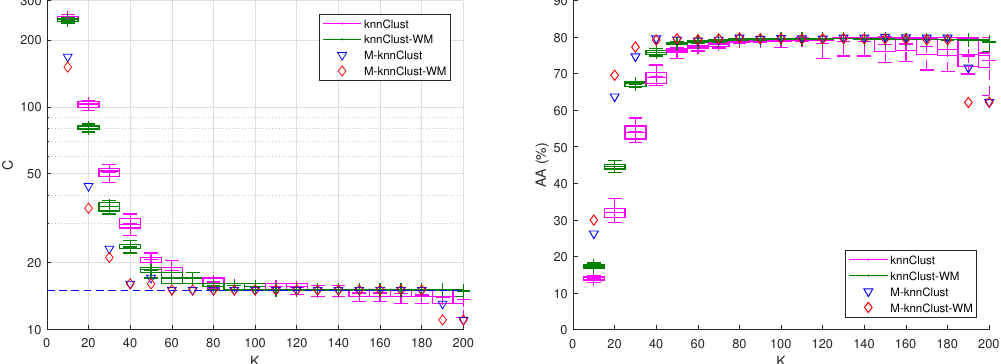
Figure 4. Comparison of KNNCLUST (black circles, 10 runs), M - KNNCLUST (blue triangles) and M - KNNCLUST - WM (red stars) as functions of the number of NNs K on the S4 dataset. Left: Number of clusters C found (true number of clusters as a dotted line); right: average